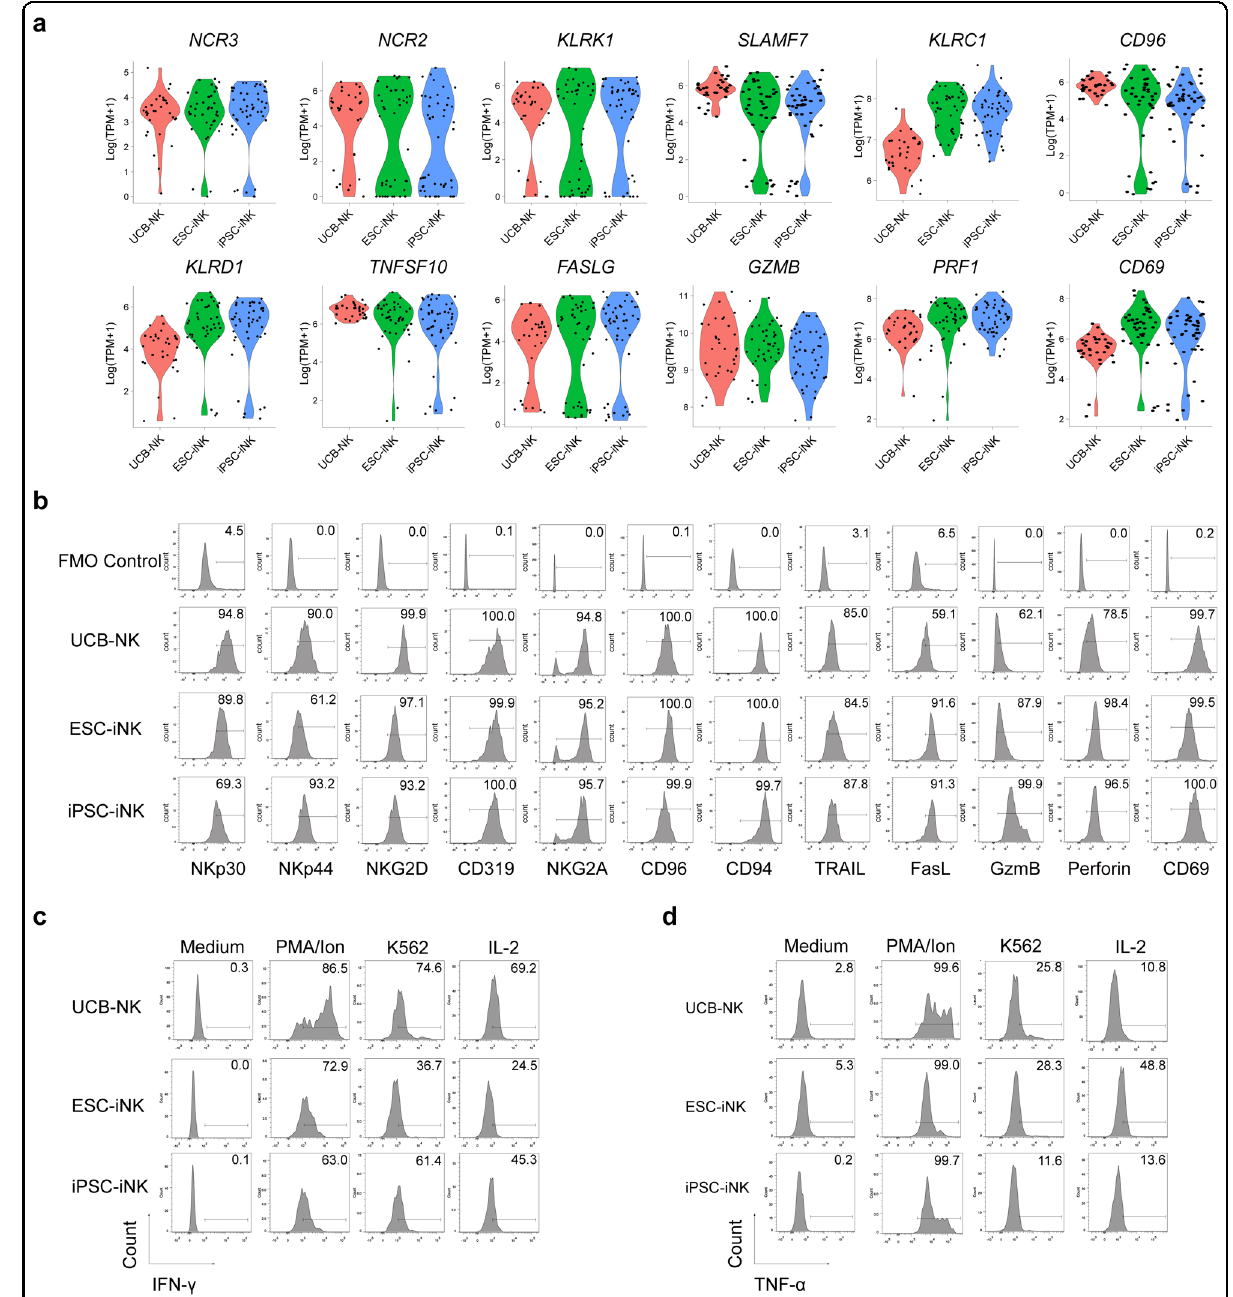
Fig. 3 Molecular features of ESC-iNK, iPSC-iNK, and UCB-NK cells. a Violin plots show the expression pro fi les of the indicated NK cell surface receptors and effectors ( NCR3 , NCR2 , KLRK1 , SLAMF7 , KLRC1 , CD96 , KLRD1 , TNFSF10 , FASLG , GZMB , PRF1 , and CD69 ) in ESC-iNK cells ( n = 41), iPSC-iNK cells ( n = 47), and UCB-NK cells ( n = 32). The expression value (TPM) of each gene was transformed with log 2 . One point represents one cell. b The expression levels of NK cell typical receptors and effectors (NKp30, NKp44, NKG2D, CD319, NKG2A, CD96, CD94, TARIL, FasL, GzmB, Perforin, and CD69) were analyzed by fl ow cytometry. c , d IFN- γ ( c ) and TNF- α ( d ) production by iNK cells upon stimulation with PMA/ionomycin, K562 tumor cells, or recombinant human IL-2. IFN- γ + or TNF- α + cells were gated on CD45 + CD3 – CD56 + NK cells. ESC: human ESC line hPSC-2; iPSC: human iPSC line